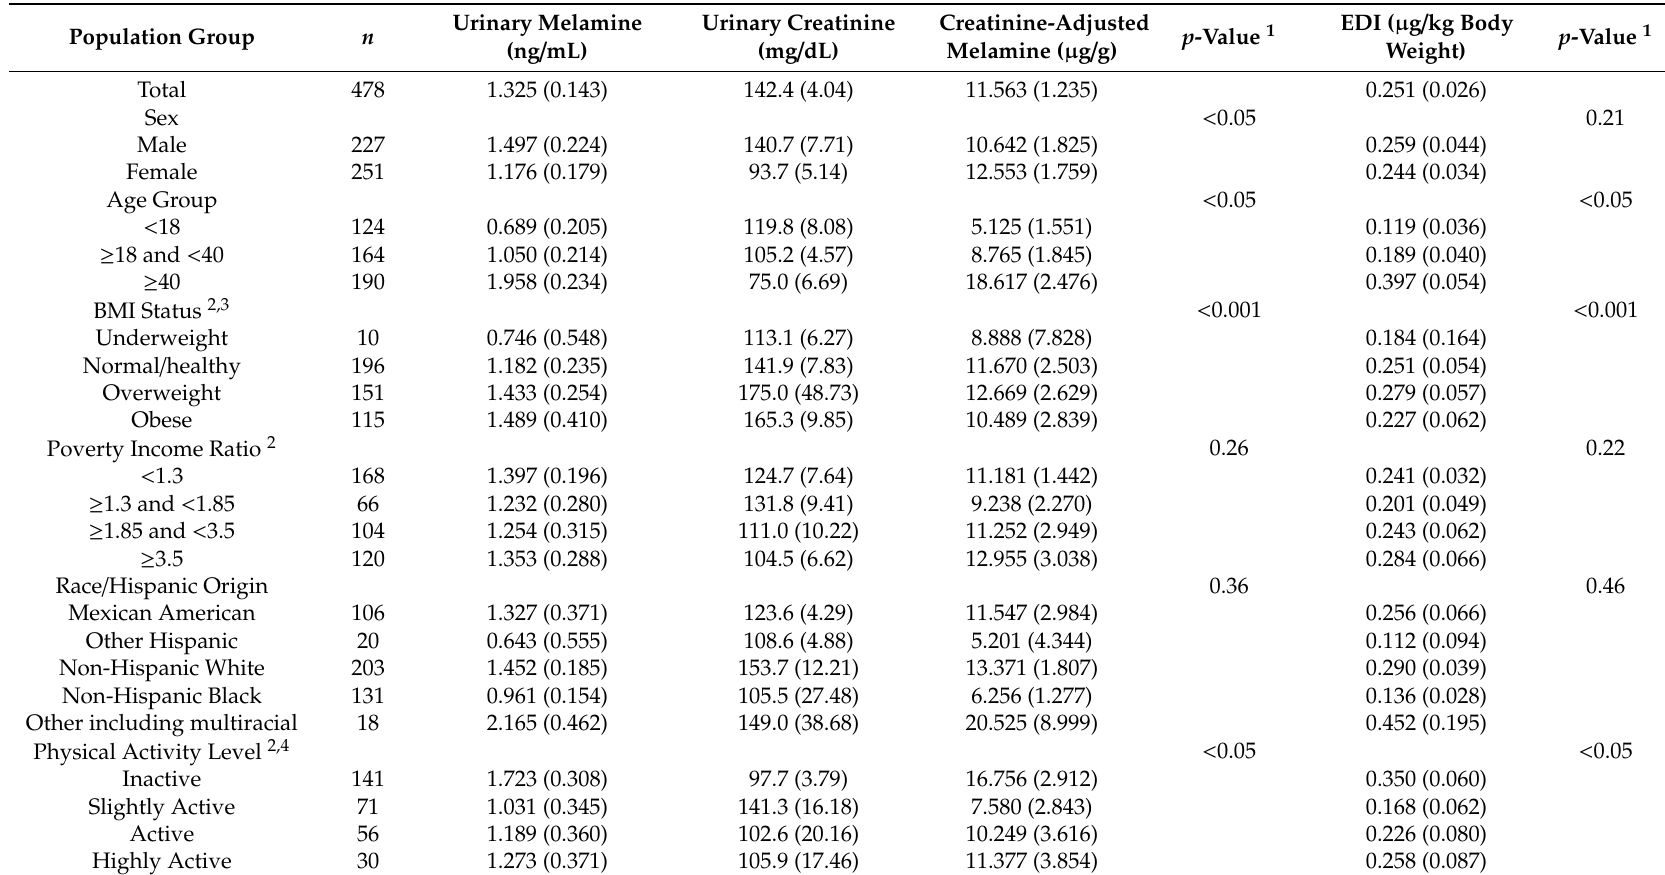
Table 1. Geometric means (SE) of urinary melamine, creatinine, creatinine-adjusted melamine, and estimated daily intake (EDI) for the US population